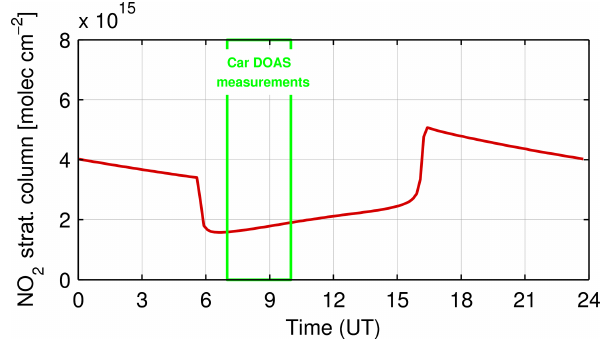
Figure 5. Stratospheric NO 2 above Vienna on 19 October 2014 (red line) as obtained from the Bremen 3d chemistry transport model (B3dCTM). The green rectangle indicates the time period of car DOAS measurements performed on that